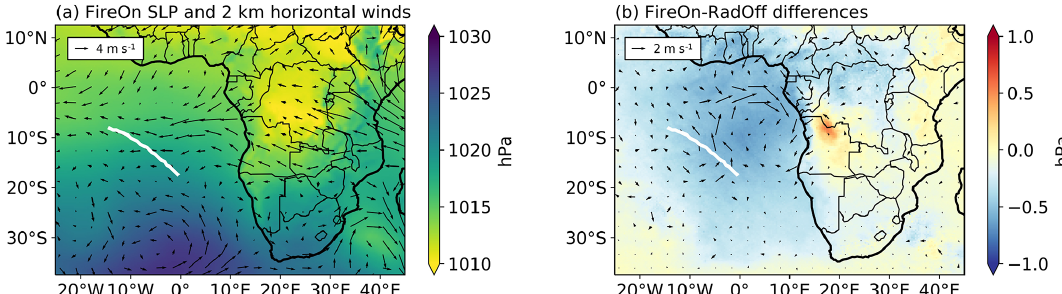
Figure 12. FireOn (a) and FireOn–RadOff differences in (b) sea level pressure and horizontal winds at 2km over the full 14–20 August 2017 period. SLP is shown as shading and wind as quivers. Note the different arrow length scaling in panels (a) and (b) for horizontal winds and their differences, respectively. The white line represents the Lagrangian trajectory